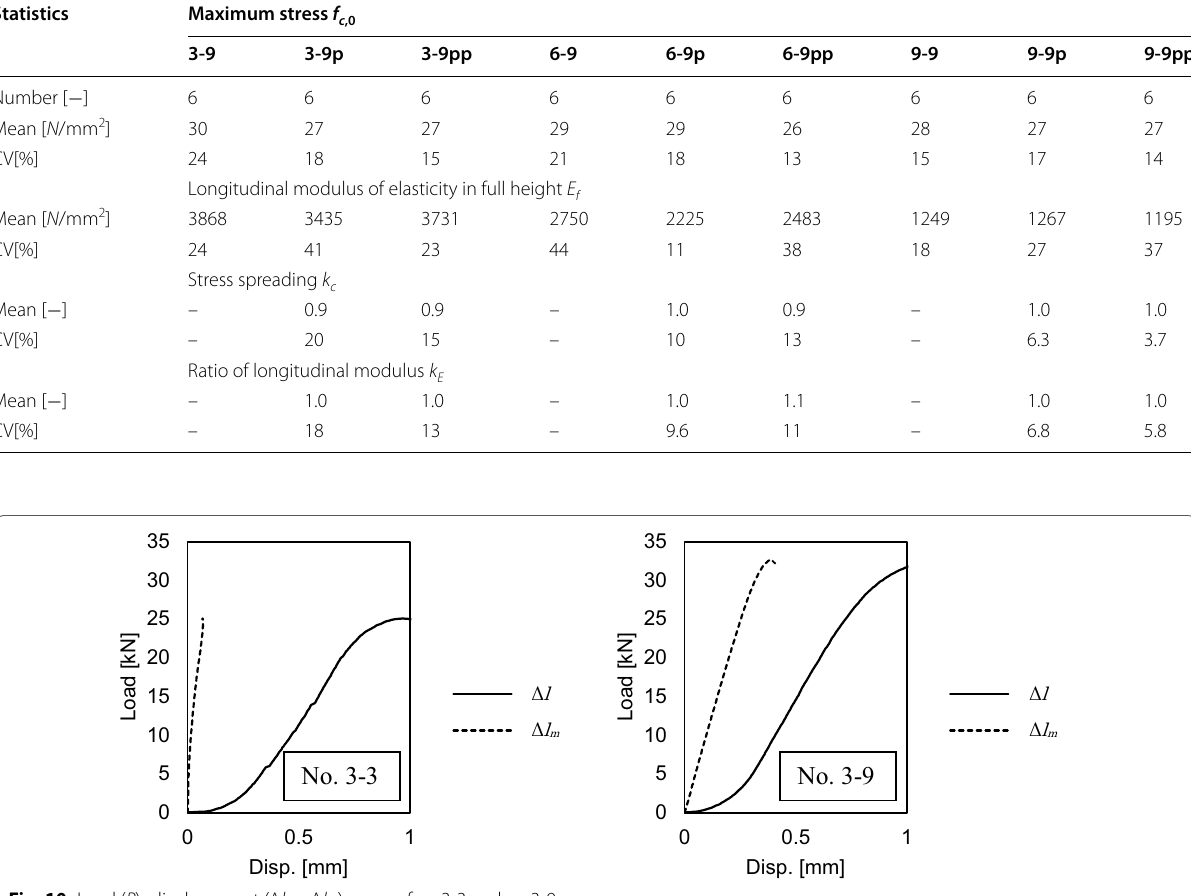
Table 2 Mean statistics of entire or partial surface-loaded specimens, stress spreading and ratio of longitudinal modulus Statistics